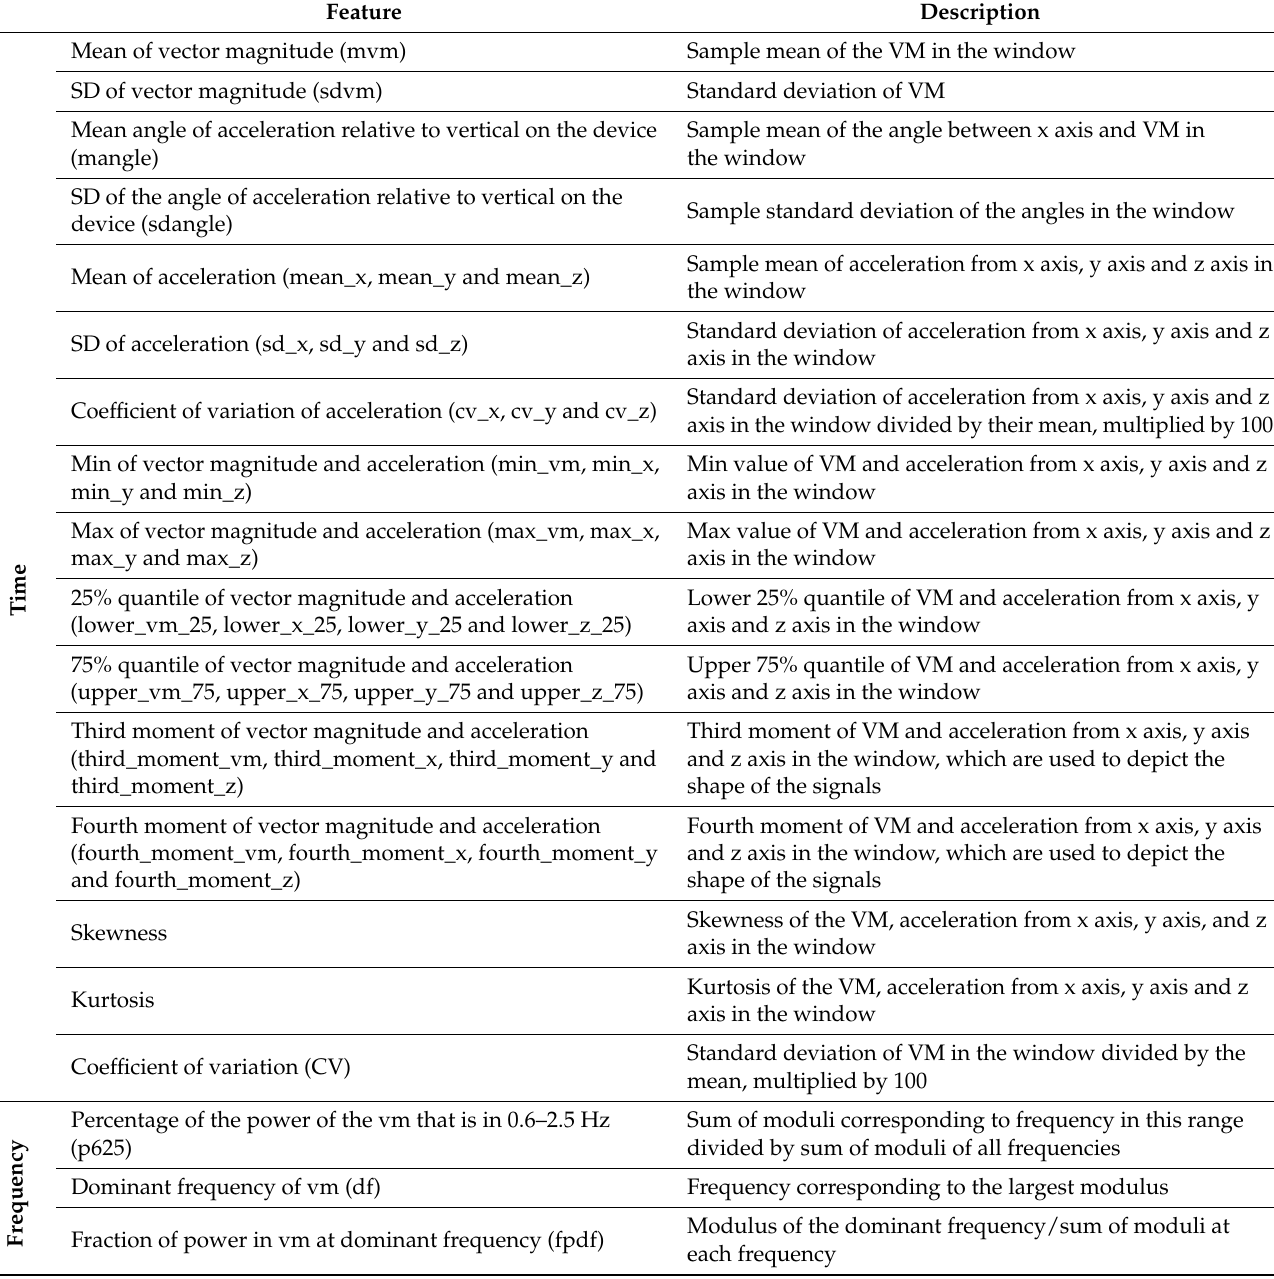
Table 1. Description of features extracted from the raw